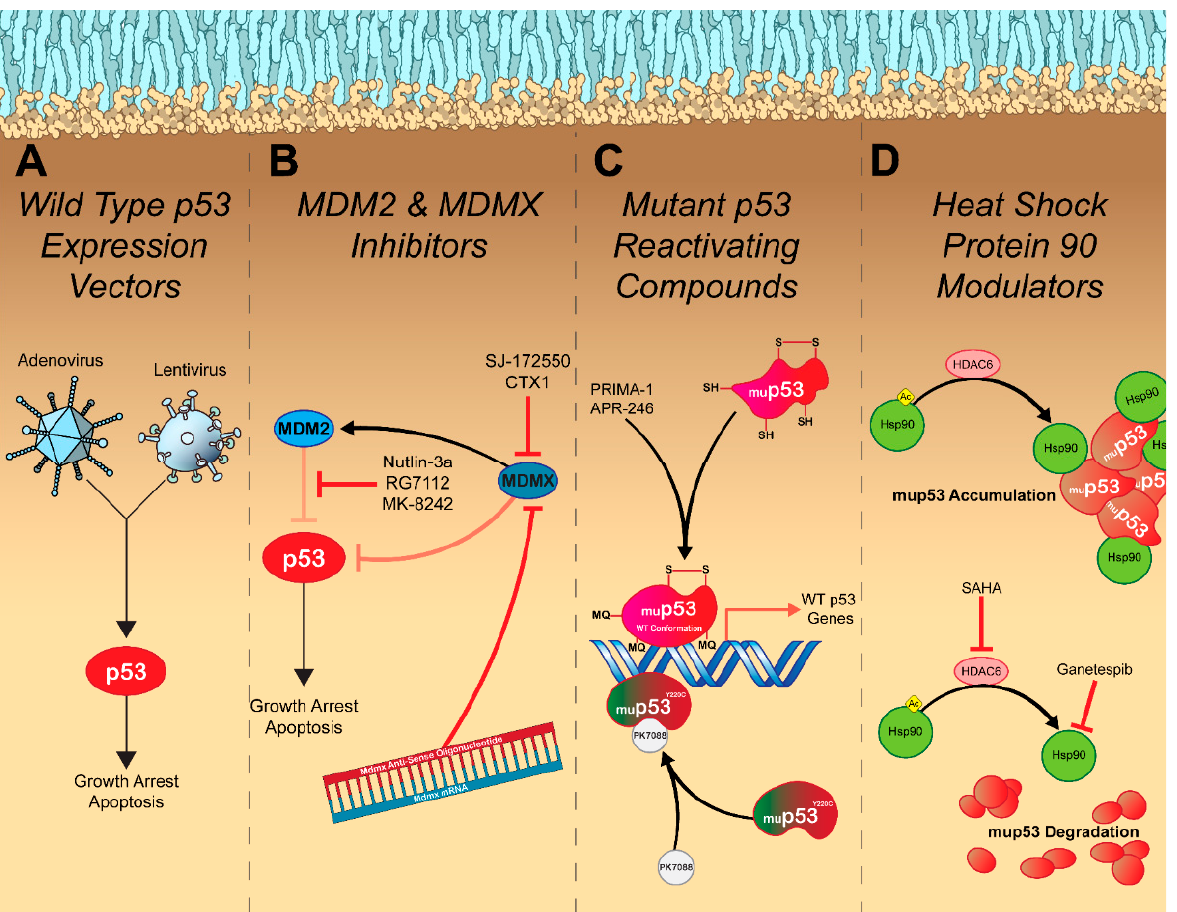
Figure 2. Therapeutic strategies for targeting p53. ( A ) Viral expression vectors (adenovirus and/or lentivirus) that encode the WT p53 protein, hijack host (cancer) cell machinery and force them to produce functional p53 protein. This leads to activation of canonical p53 signaling, resulting in growth arrest and apoptosis induction. ( B ) MDM2 and MDMX inhibitors function to block the negative regulation of p53 by these proteins, resulting in p53 release and activation of tumor suppressive pathways such as growth arrest and apoptosis. In addition to small molecule inhibitors of the p53 binding site on MDM2 and MDMX, antisense oligonucleotides can be directed against Mdmx mRNA by targeting the boundary of exon 6 resulting in downregulation of MDMX. ( C ) Mutations of p53 protein may cause conformational changes in the DNA binding domain. Compounds that stabilize the mutant protein so that the WT conformation of the DNA binding domain can be restored are able to facilitate the expression of WT p53 target genes resulting in growth arrest and apoptosis. These include PRIMA-1/APR-246, which following conversion into methylene quinuclidinone (MQ) can covalently attach to cysteine residues, which stabilizes the binding of mup53 to the WT proteins DNA response elements. Additionally, mutations can create novel binding domains on the mup53 protein. The Y220C mutation generates a binding pocket on mup53 that when bound by the small molecule PK7088 stabilizes the mutant protein in its WT conformation enabling binding to DNA response elements. These compounds enable restoration of WT p53 transcriptional functions resulting in cell cycle arrest and apoptosis. ( D ) Heat shock protein 90 (Hsp90) functions to stabilize mup53, preventing its degradation. Addition of the Hsp90 inhibitor, ganetespib, blocks this interaction and facilitates degradation of mup53. This can also be achieved by inhibiting histone deacetylase activity with suberoylanilide hydroxamic acid (SAHA), which causes Hsp90 to remain acetylated, which blocks its chaperone activity. Legend: Arrows represent activation pathways, hammers represent inhibition, and faded hammers represent inhibitory pathways that are being repressed by the signal